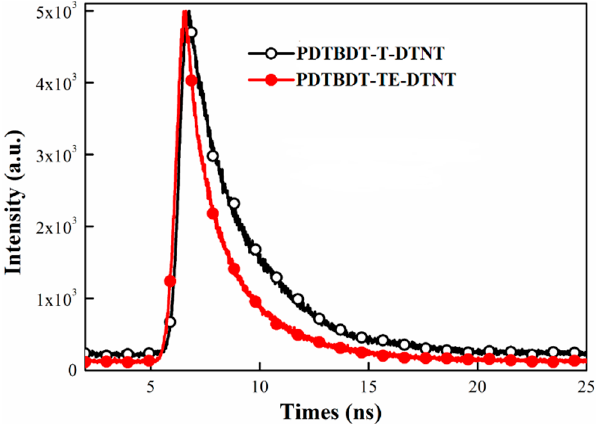
Figure 8. Time-resolved photoluminescence of the polymers on the dilute solution of toluene.